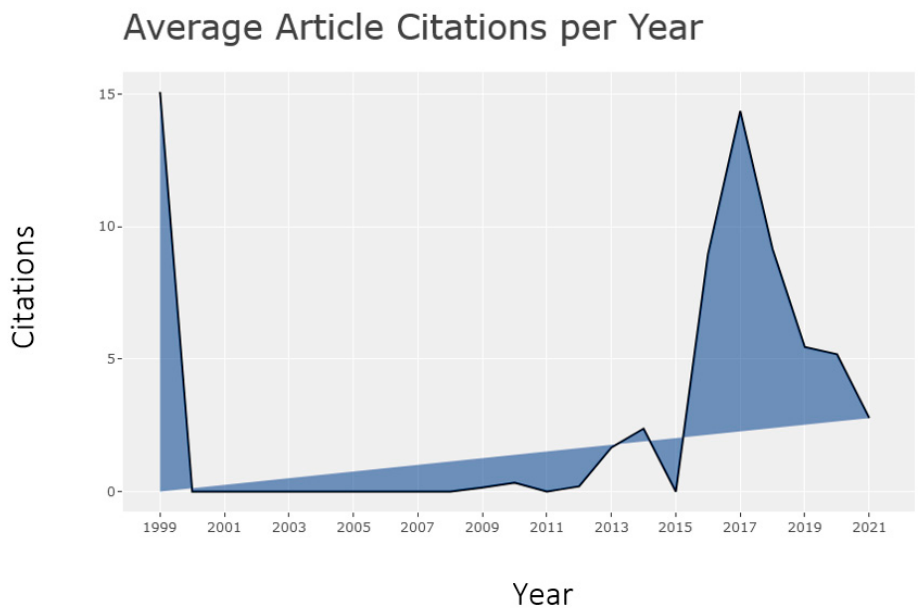
Figure 5. Average article citations per year. Source: Scopus-Biblioshiny. The journals with the most published articles in the field of smart farming or precision farming for the years 2017–2021 are presented in Table 1. “Sustainability” was the journal with the highest number of published articles on smart farming and precision farming (48) during the period 2017–2021. “IEEE Access” ranked second with 46 articles found on smart farming. The journal “Sensors” published 42 articles, while the journal “Computers and Electronics in Agriculture” published 39 articles. In addition, many of the most-cited journals in the field of smart farming are indexed by Scopus and Scimago Journal and Country